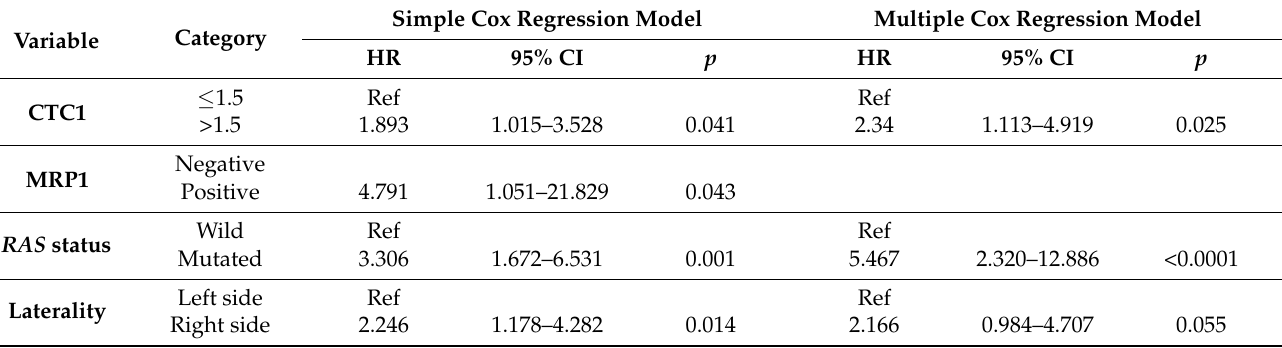
Table 2. Estimate of the parameters of the simple and multiple Cox regression model for overall survival from metastatic colon cancer.